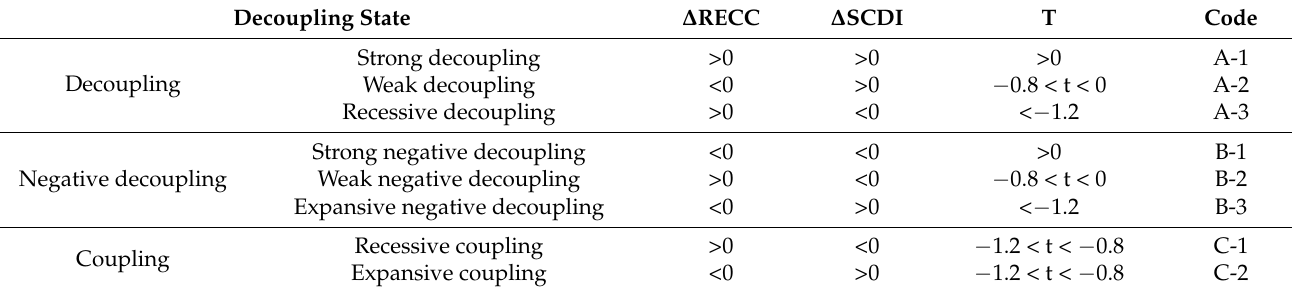
Table 4. Rules of decoupling state judgment between RECC and